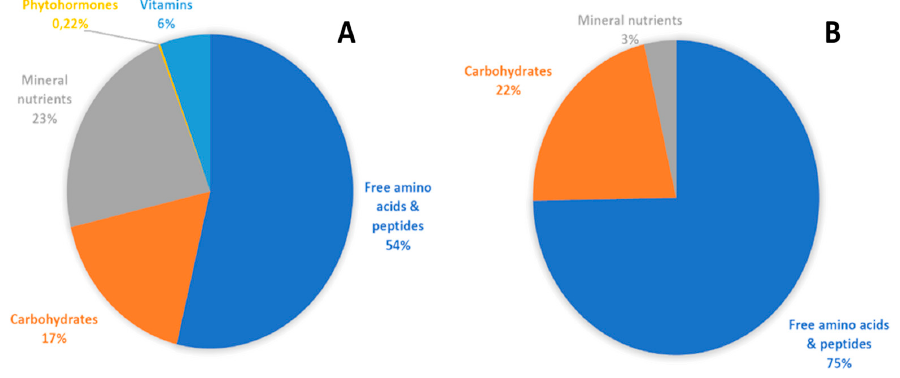
Figure 1. Main components (as percentage of the total) of tropical plant extract enriched with micronutrients ( A ) and vegetal-derived protein hydrolysate ( B ) tested in the present trial.